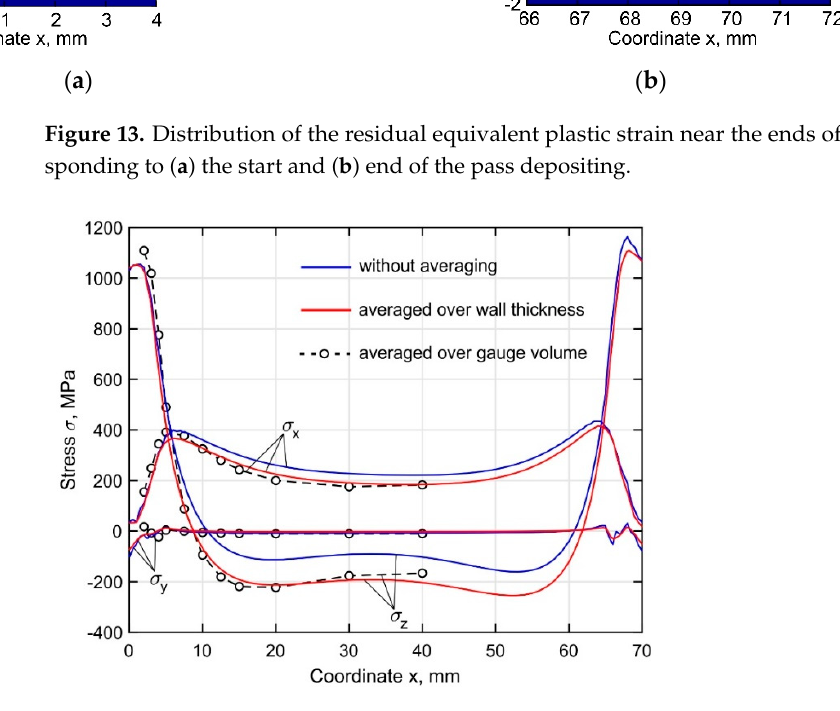
Figure 14. Distribution of the calculated residual stress field components along the length of the buildup at a distance of 2 mm from the substrate. buildup at a distance of 2 mm from the